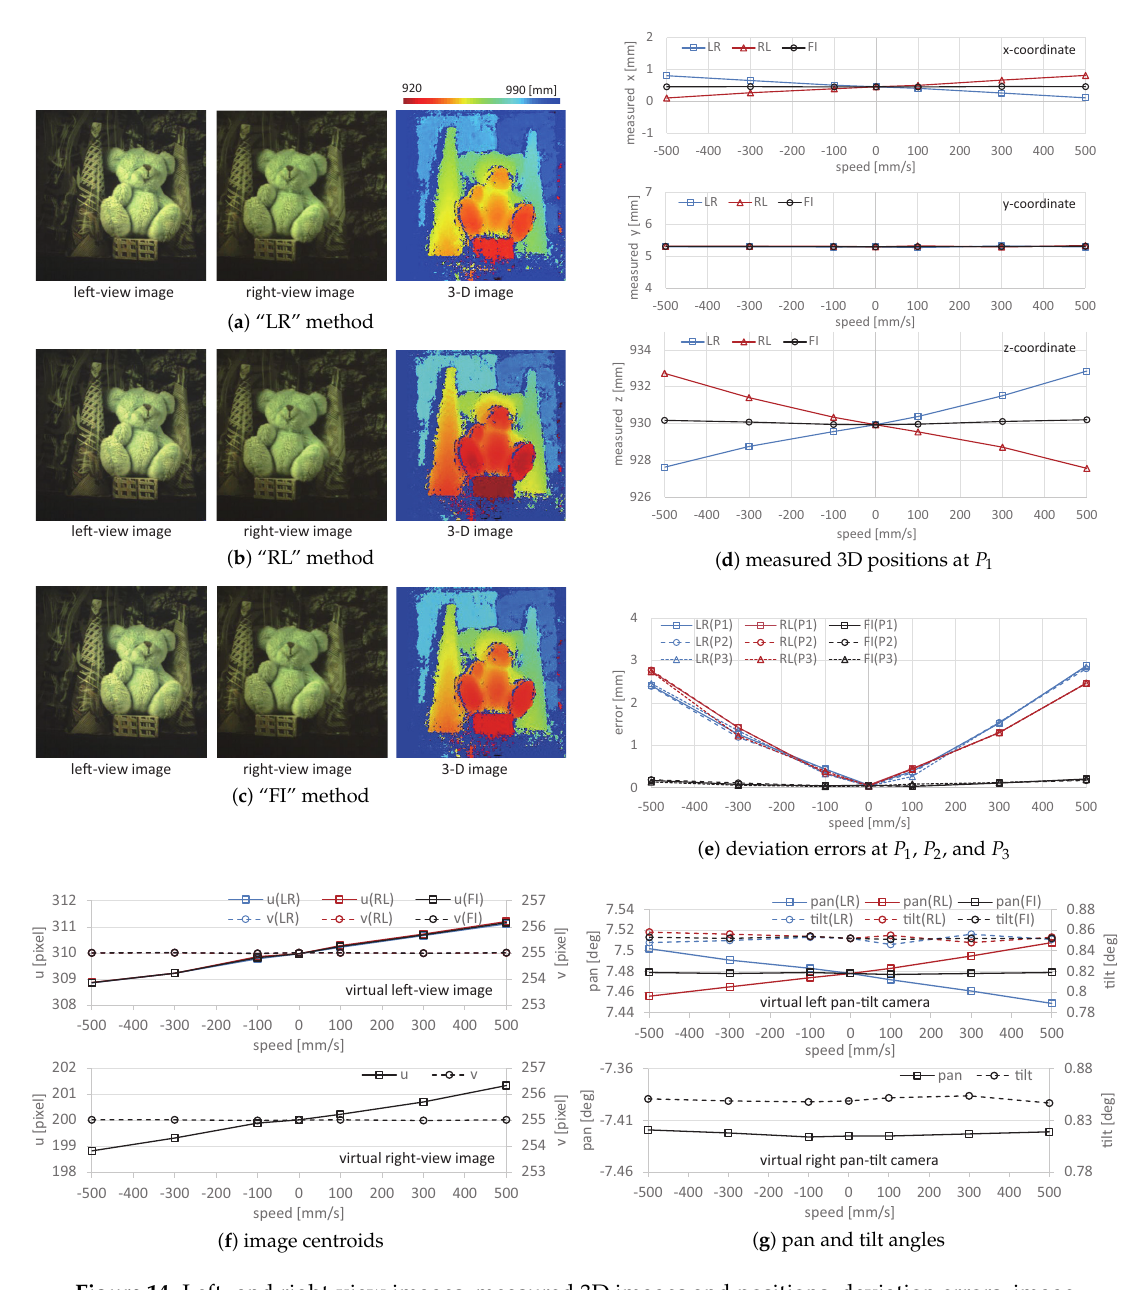
Figure 14. Left- and right-view images, measured 3D images and positions, deviation errors, image centroids, and pan and tilt angles of virtual left and right pan-tilt cameras when moving at 500 mm/s in the x -direction: ( a ) “LR” method; ( b ) “RL” method; ( c ) “FI” method; ( d ) measured 3D positions at P 1 ; ( e ) deviation errors at P 1 , P 2 , and P 3 ; ( f ) image centroids; ( g ) pan and tilt